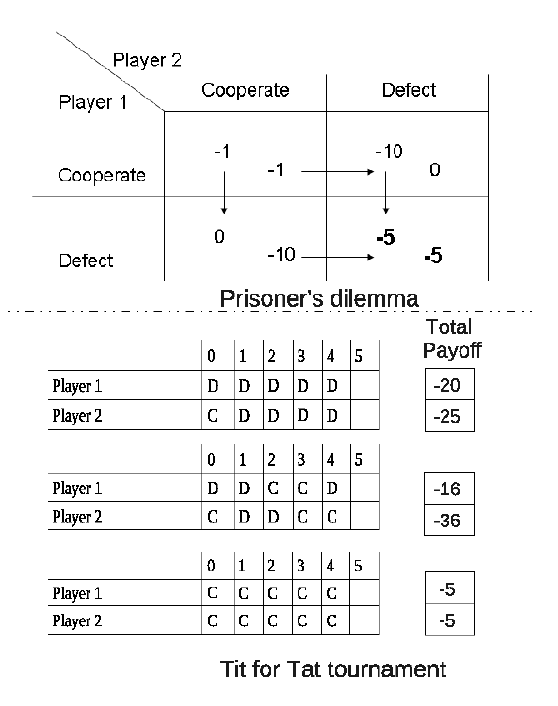
Figure 3. The tit-for-tat strategy in